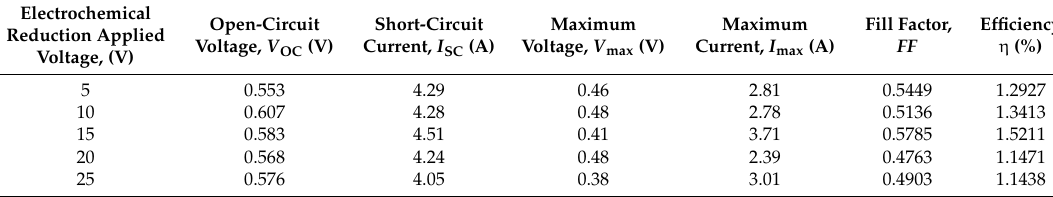
Table 4. V OC , I SC , FF , and η for DSSC calculated from Figure